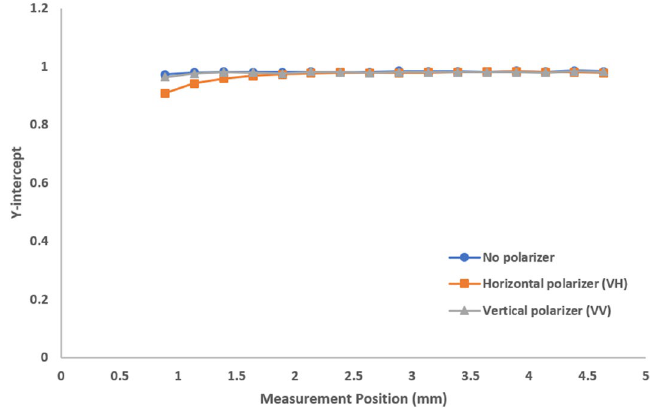
Figure 10. Y-intercept as a function of measurement position for 1000-fold diluted milk showing reasonable scattering intensity, any polarizer detection will lead to a near-perfect intercept approaching